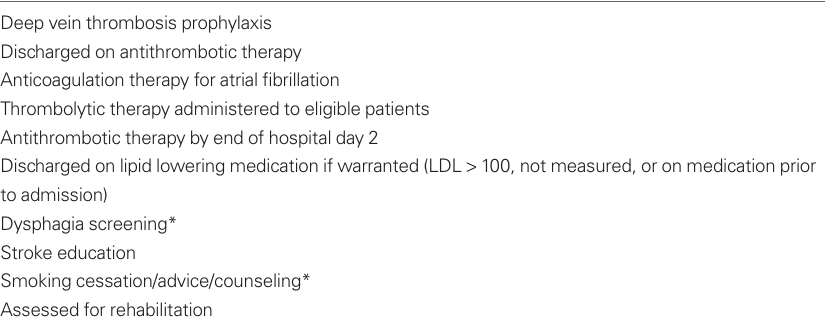
Table 2 | JCAHO standardize stroke performance measures (http://www.jointcommission.org/